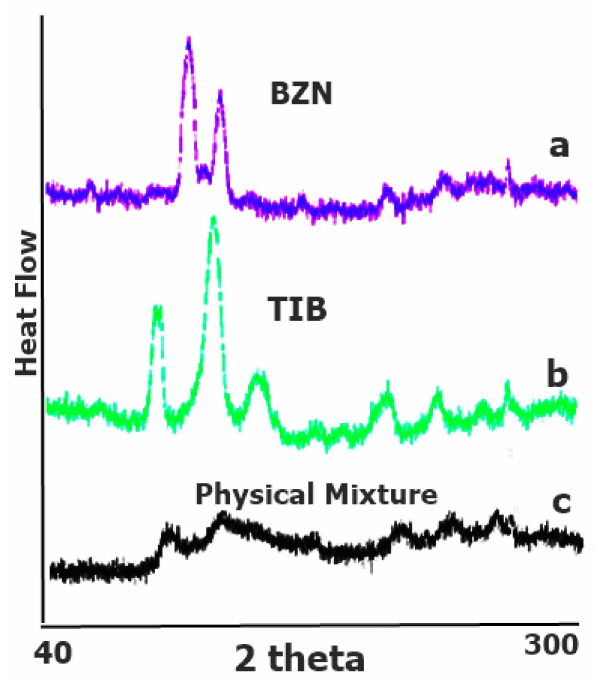
Figure 7. PXRD pattern of ( a ) BZN, ( b ) TIB, and ( c ) the physical mixture.